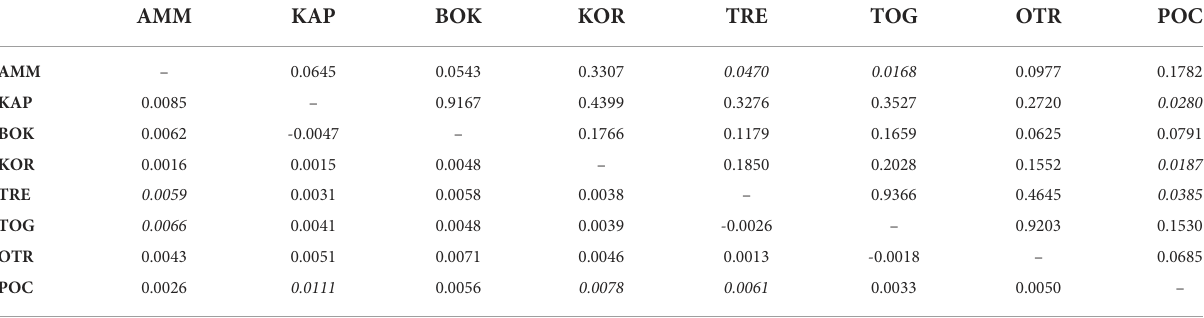
TABLE 4 Pachygrapsus marmoratus pairwise genetic differentiation based on 14 neutral loci. AMM KAP BOK